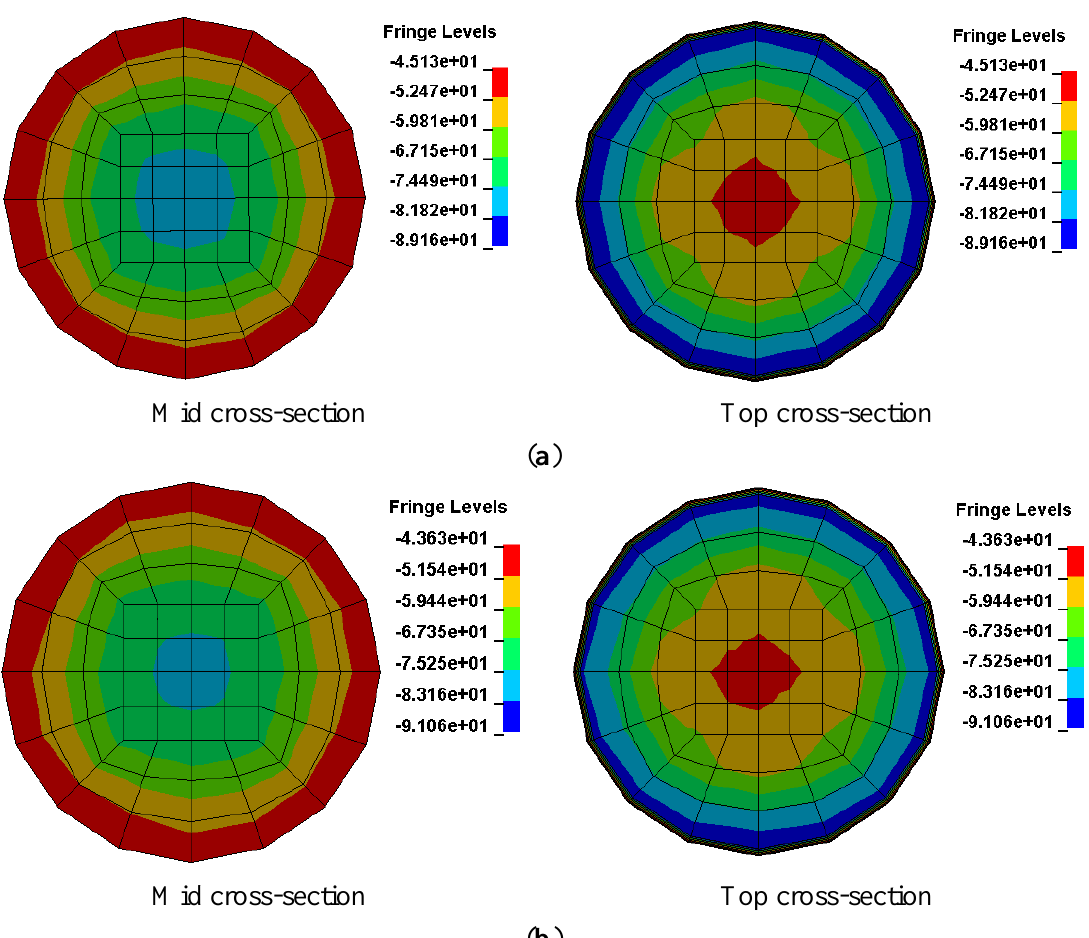
Figure 8. Axial strain-normalized strength relationship of CFFT with LRS-FRP with different column